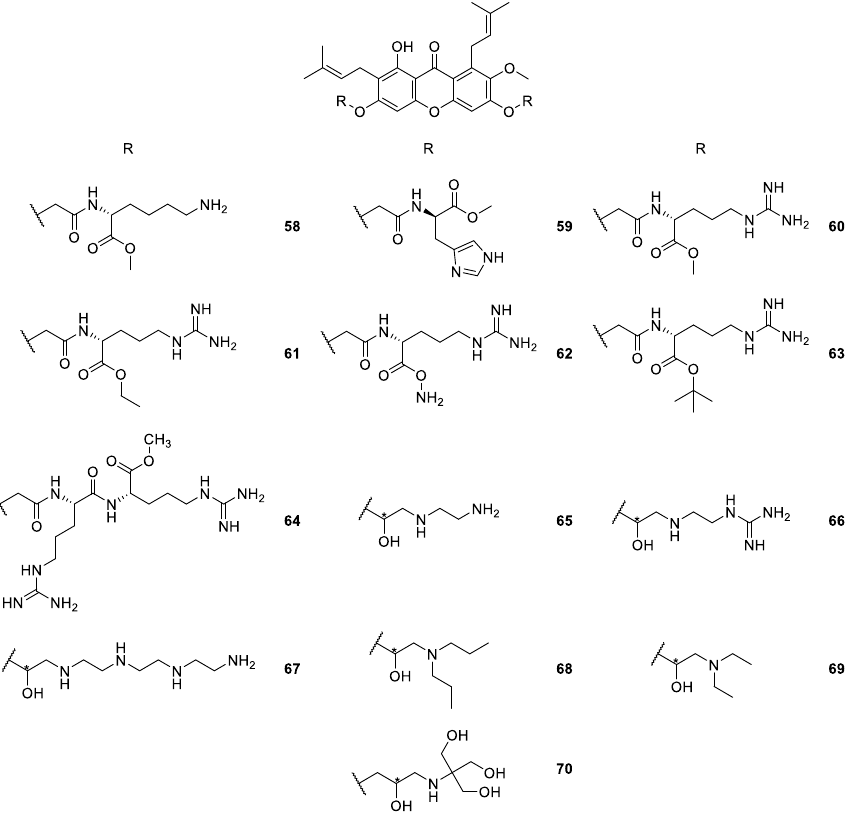
Figure 8. Structures of derivatives of α -mangostin 58 – 70 .